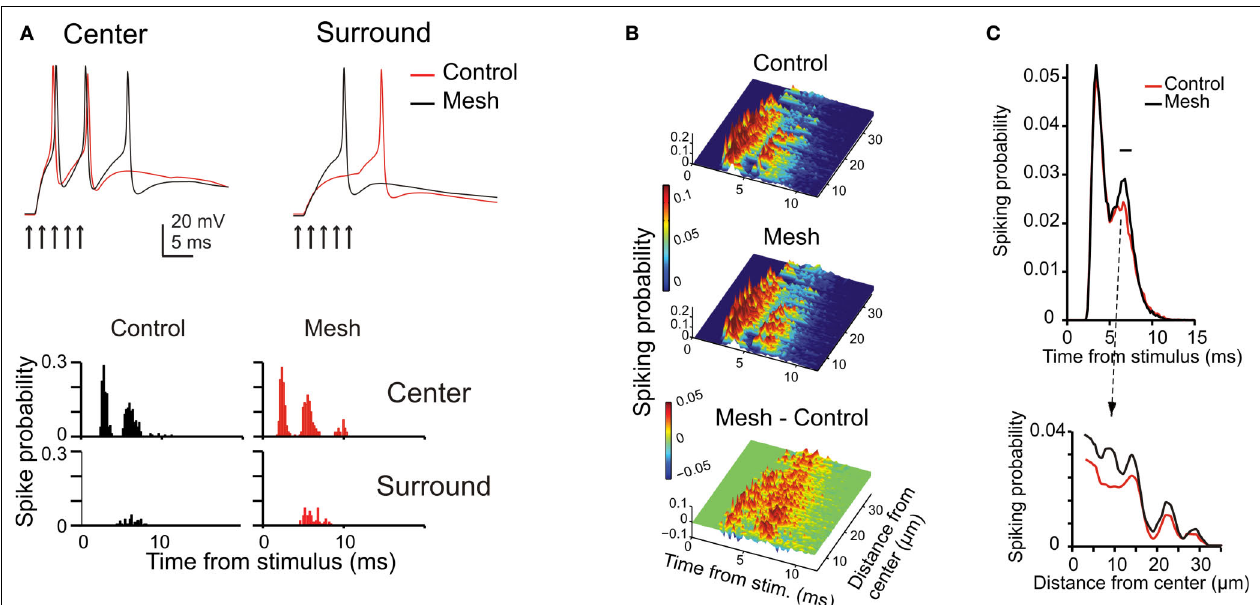
FIGURE 6 | The impact of network topology on granular layer responses. Granular layer response elicited by a mf burst (fi ve spikes at 500 Hz on eight contiguous mfs) using the control or the mesh-like network confi gurations (see Materials and Methods). (A) The traces show that responses in the center have shorter latency and higher number of spikes than in the surround of the activated area (exemplar traces are taken at 10 and 32 µm from the core; arrows mark the time of stimulation). The PSTHs (bin width 0.5 ms) were normalized by the number of simulations. The mesh-like confi guration reduces the overall level of inhibition, with a more evident effect in the surround, so that the PSTH of peripheral cells shows a remarkable increase in the second/third spike fi ring probability. (B) The PSTHs of responding GrCs were ordered according to GrC distance from the stimulus center and color coded. In the control network confi guration, most neurons fi re a high frequency spike doublet with short